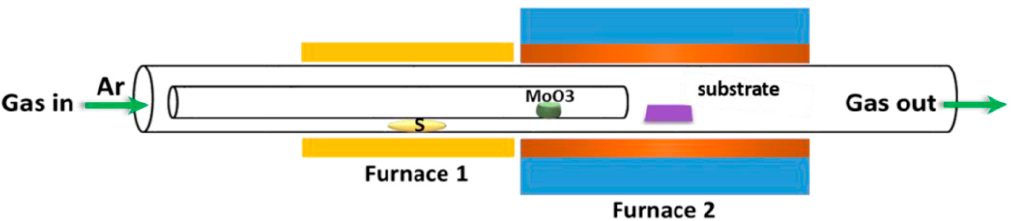
Figure 4. Schematic illustration of CVD growth methods for MoS 2 growth. Reproduced with permission from American Chemical Society Publishing Group in Ref [59]. permission from American Chemical Society Publishing Group in Ref